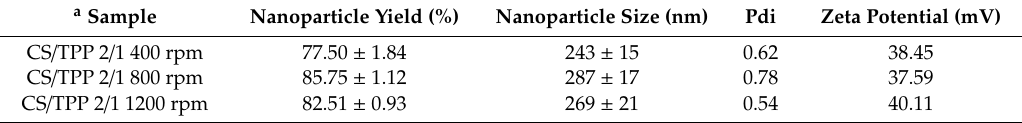
Table 2. Nanoparticle yield (%), particle size and zeta potential of CS / TPP 2 / 1 at di ff erent stirring